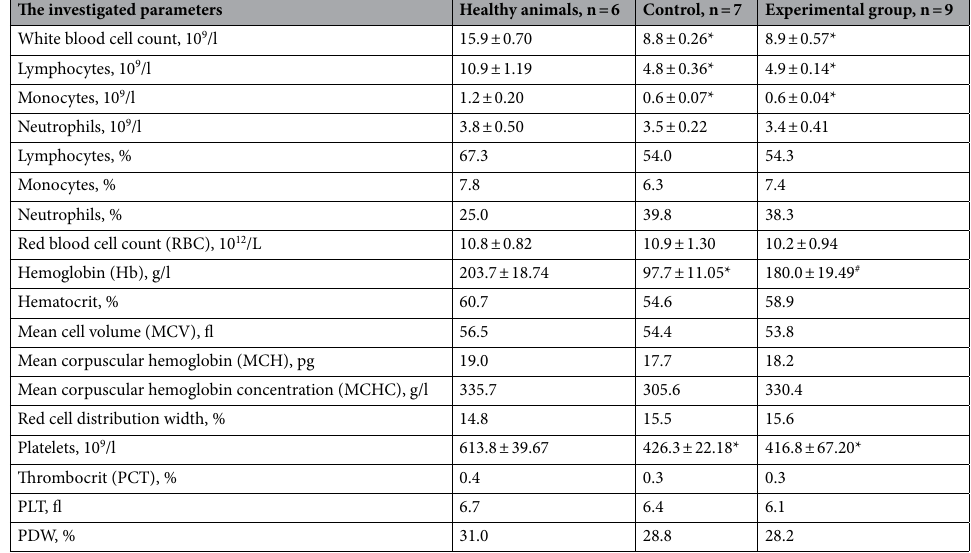
Table 4. Hematological effects of polyphenol concentrate, (M ± m). *P < 0.05 compare to the value in the group of healthy animals. # P < 0.05 compare to the value in the group of control animals. Results presented are mean ± standard error of the mean.